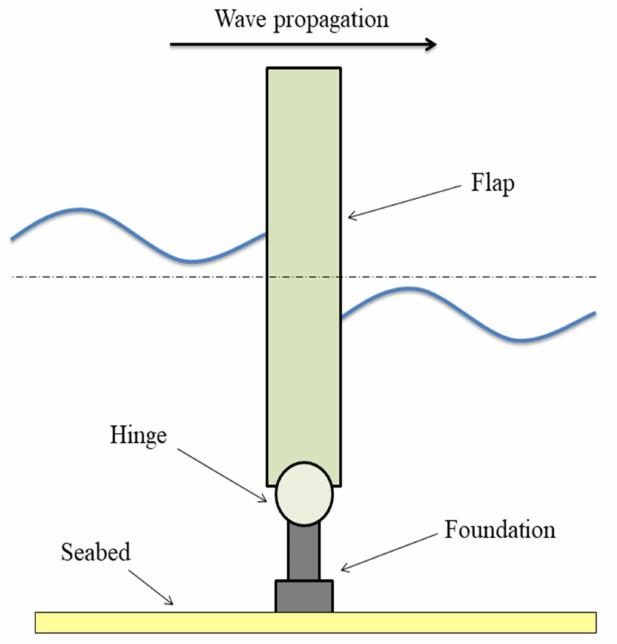
Figure 2. Schematic view of an oscillating wave surge converter.